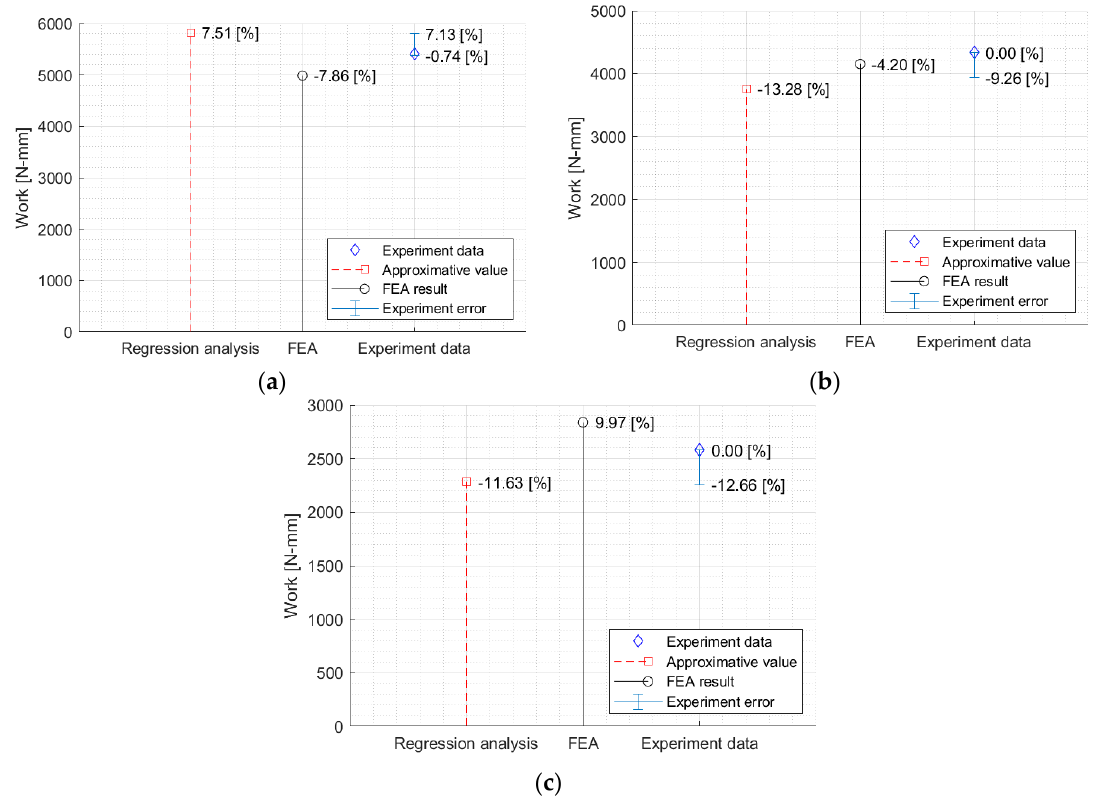
Figure 16. Experimental and FEA results to verify the regression equation. ( a ) Decrease in inner diameter by 8% ( 𝜼 = −𝟖 ); ( b ) Normal inner diameter ( 𝜼 = 𝟎 ); ( c ) Increase in inner diameter by 8% ( 𝜼 = 𝟖 ).